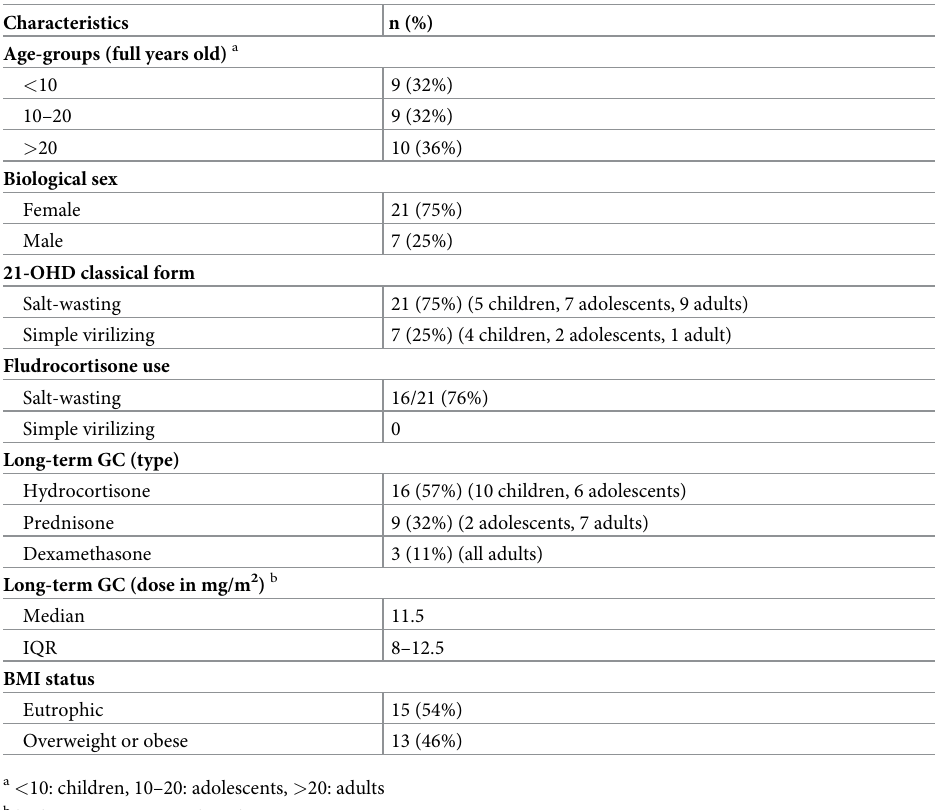
Table 2. Clinical characteristics of 21-OHD subjects (n = 28).